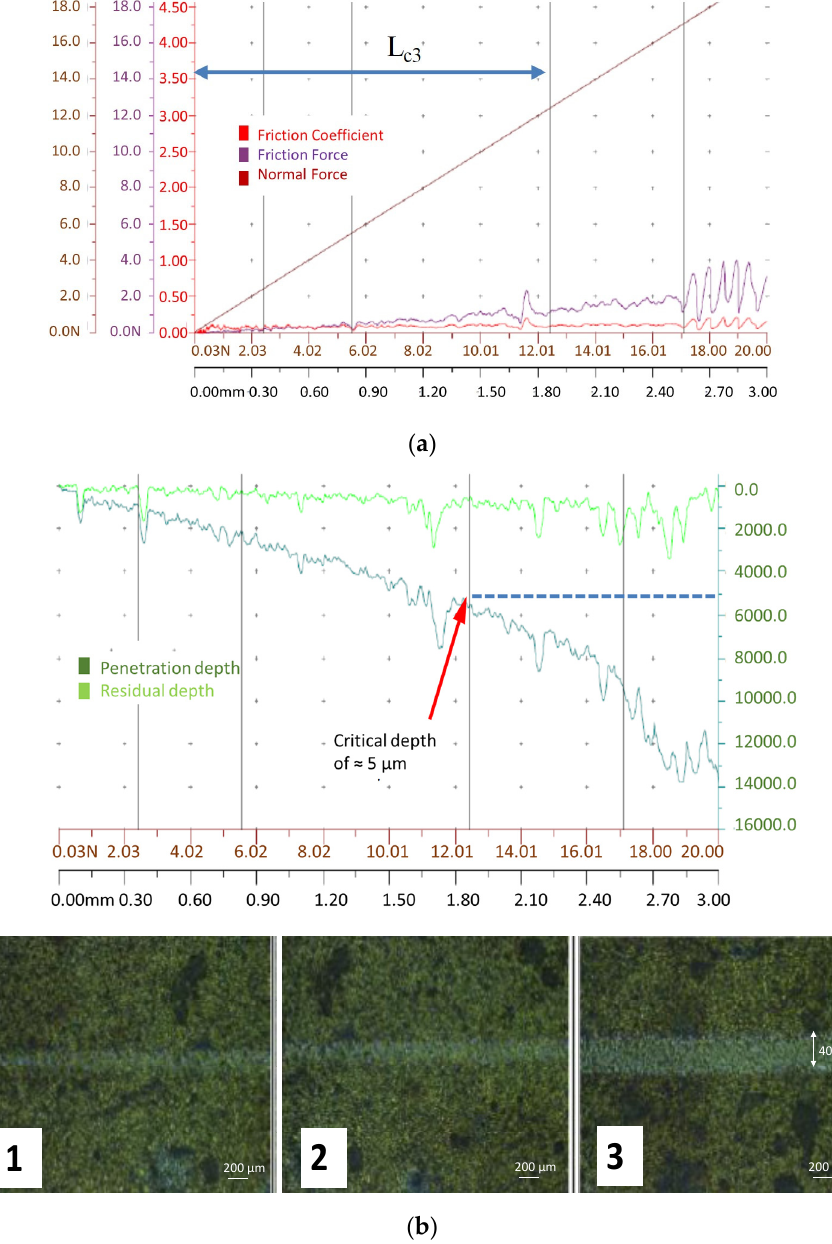
Figure 7. Original plots of the coefficient of friction and friction force ( a ) and optical micrographs of the scratching scars for magnification × 20 ( b ) for TiAlN samples oxidized at 900 ◦ C for 30 min. Symbols of test stages: 1, failure initiation; 2, spalling; 3,